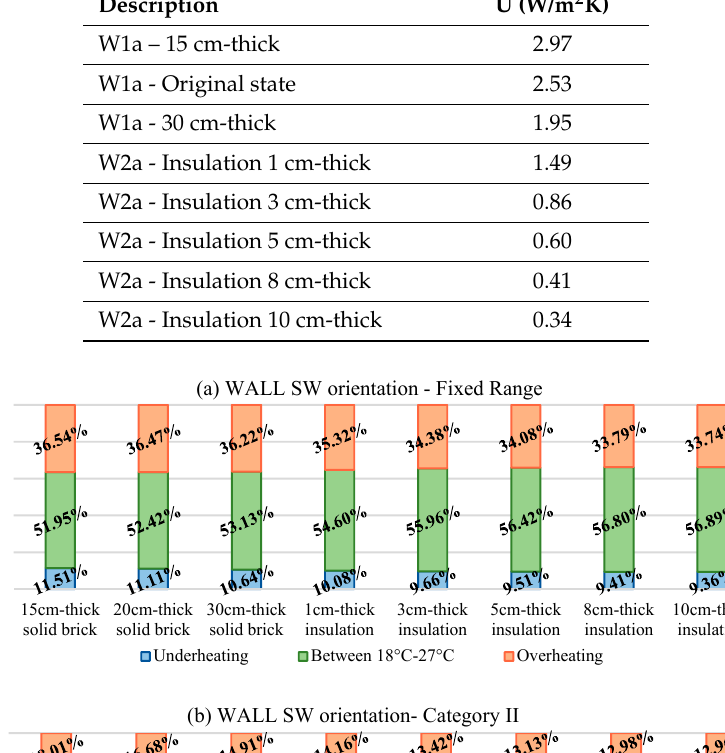
Table 11. Thermal transmittance of wall W2 with SW orientation according to the insulation thickness used.